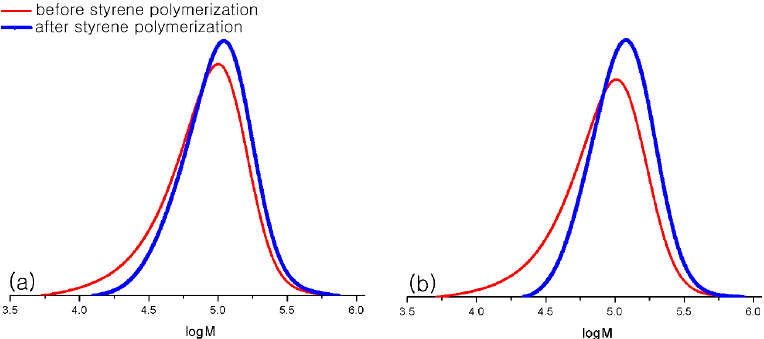
Figure 2. GPC curves of the polymers before and after styrene polymerization: ( a ) entry 4; ( b ) entry 5 in Table 2.